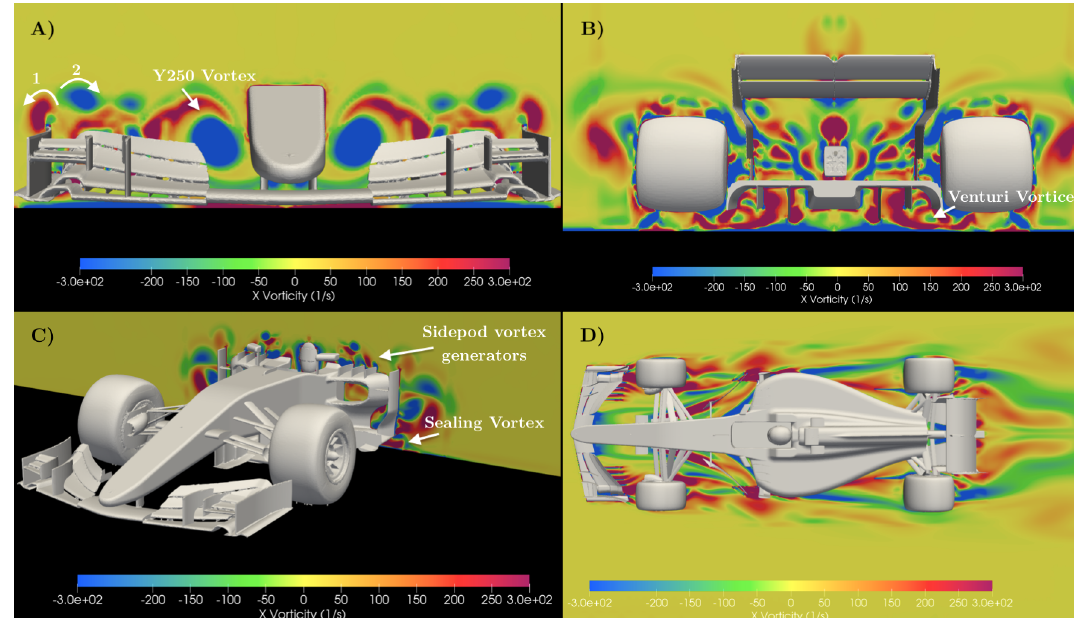
Figure 10. Several axial vorticity contours: ( A ) YZ plane at 0.65 m in the X direction, ( B ) YZ plane at 3.65 m in the X direction, ( C ) YZ plane at 2.60 m in the X direction, and ( D ) XY plane at 0 m in the Z